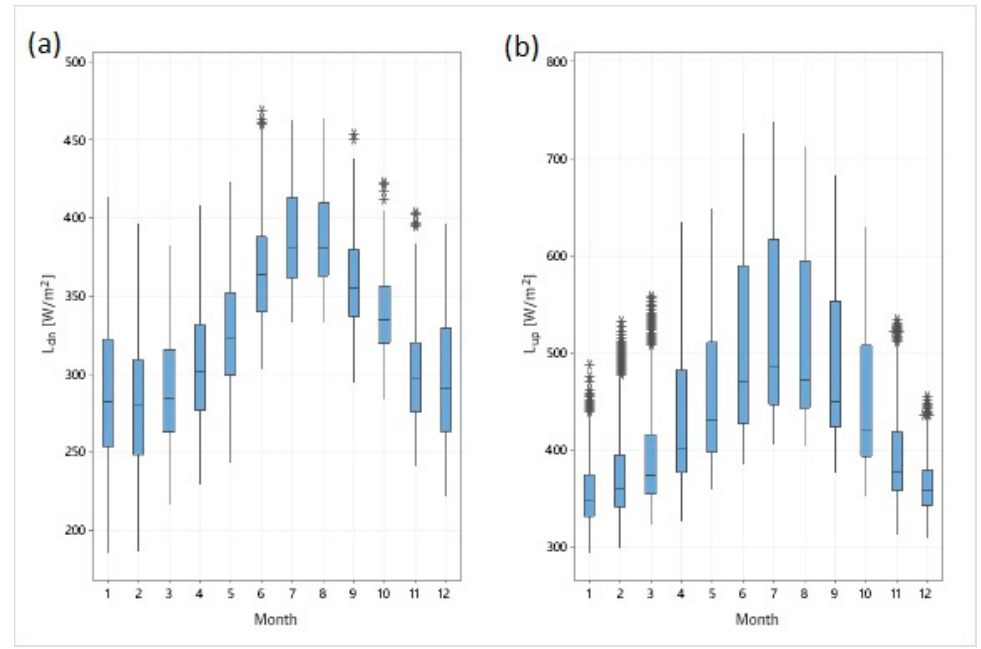
Figure 10. Monthly boxplots of ( a ) downward ( L dn ) and ( b ) upward ( L up ) longwave irradiances at Athalassa.